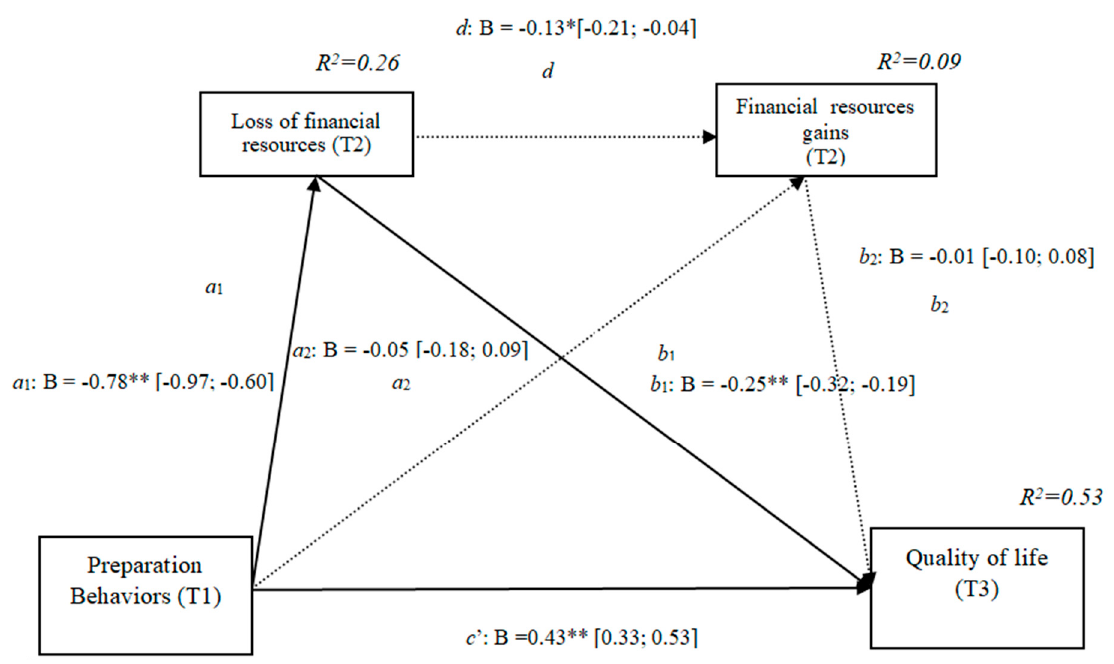
Figure 5. Non-standardized B coefficients, confidence intervals, and statistical significance for financial losses and gains. [95% CI]; * p < 0.05; ** p < 0.01.